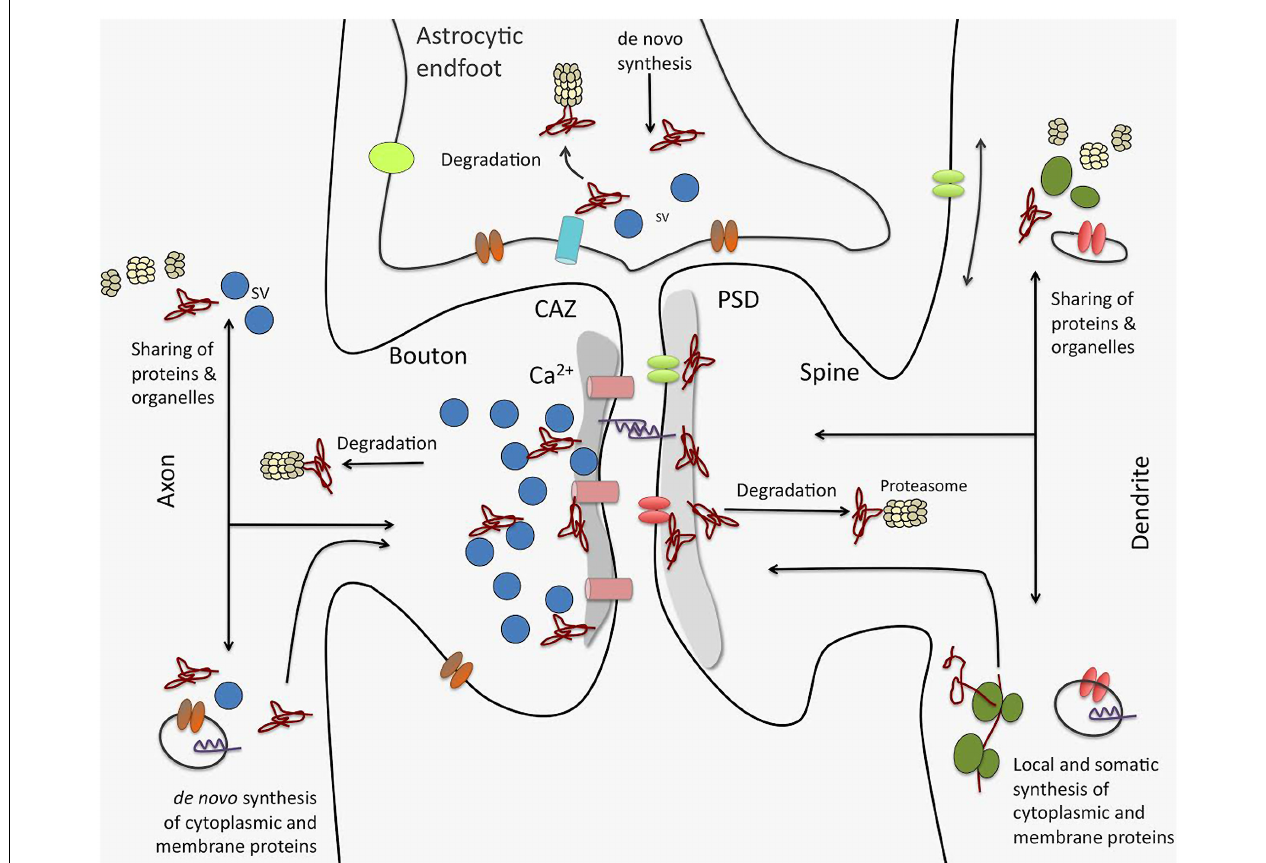
sharing of proteins, molecular machines (e.g., proteasomes, ribosomes), and organelles between synapses seems to be an important factor in regulating the protein equipment of individual synapses. Sharing of proteins and organelles can occur via intracellular transport processes as well as via diffusion in the cell membrane. Interactive regulation of these processes for protein assemblies and individual proteins is thought to determine protein composition in synapses and thereby govern their individual functionality, and in turn, their contribution to neuronal networks. CAZ, cytomatrix at the active zone; PSD, postsynaptic density; SV, synaptic